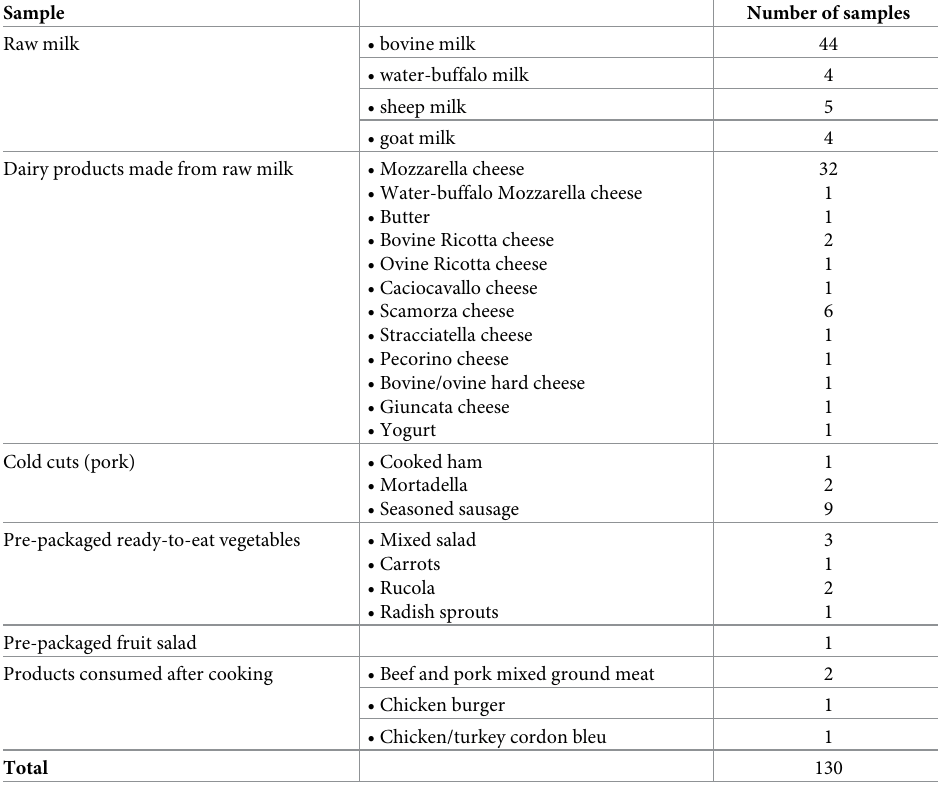
Table 1. Number and type of samples tested for detection of Yersinia enterocolitica